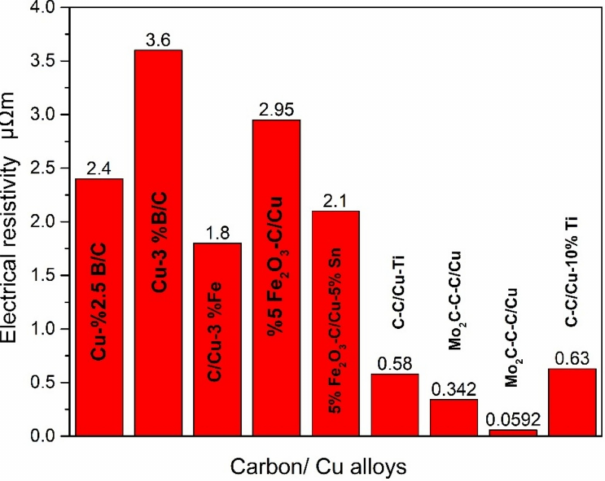
Figure 7. Electrical resistivity of carbon/Cu